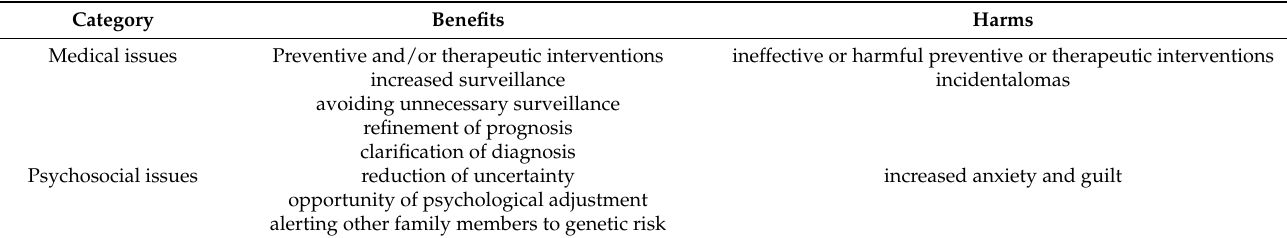
Table 1. Potential benefits and harms of genetic testing for neurodegenerative disorders (modified from [87]).